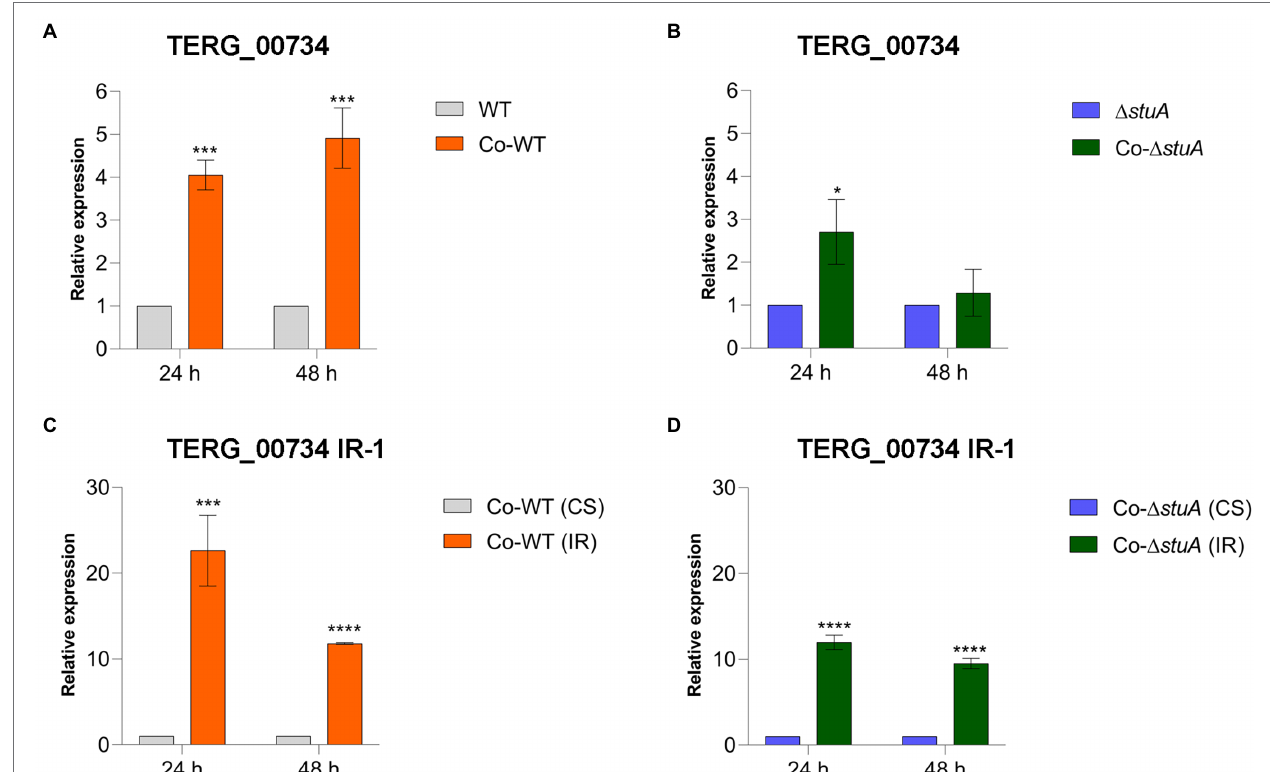
FIGURE 4 | Relative expression of the CS isoform of TERG_00734 in co-culture with keratinocytes with (A) WT and (B) Δ stuA strain, taking the level of transcripts of the fungal cells as the reference for normalizing conditions for each strain. Relative expression of the IR isoform of TERG_00734 in co-culture with keratinocytes with (C) WT and (D) Δ stuA strain, taking the levels of CS transcripts for each strain as the reference of normalizing condition. Statistical analyses for transcript quantification experiments were carried out using unpaired t -tests, and statistical significance was determined by the Holm-Sidak method considering * p < 0.05, *** p < 0.001, and **** p <